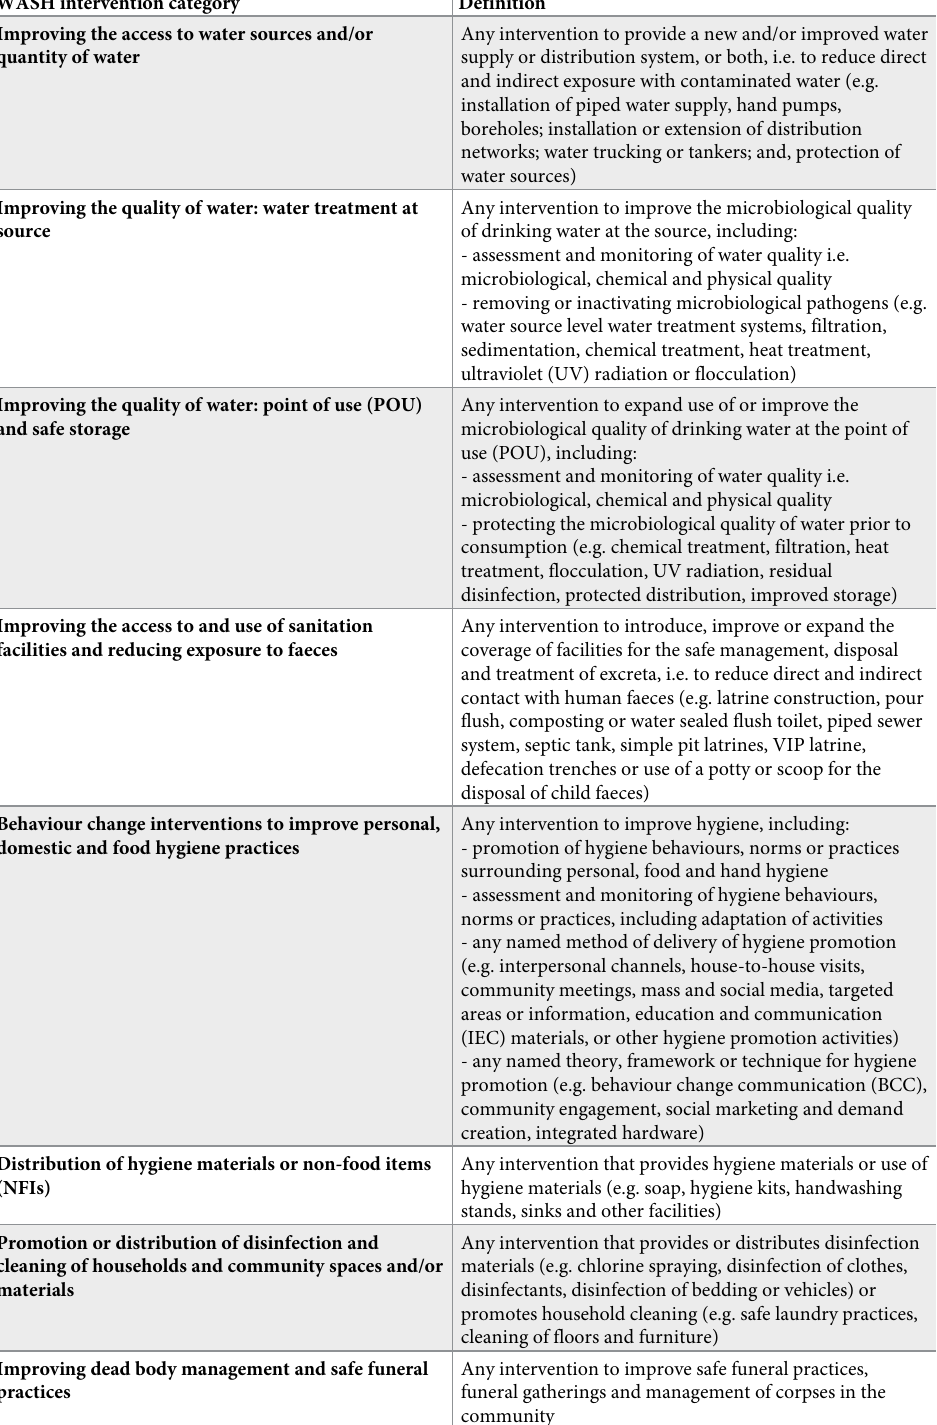
Table 1. Categories and definitions of water, sanitation and hygiene (WASH) interventions included in the